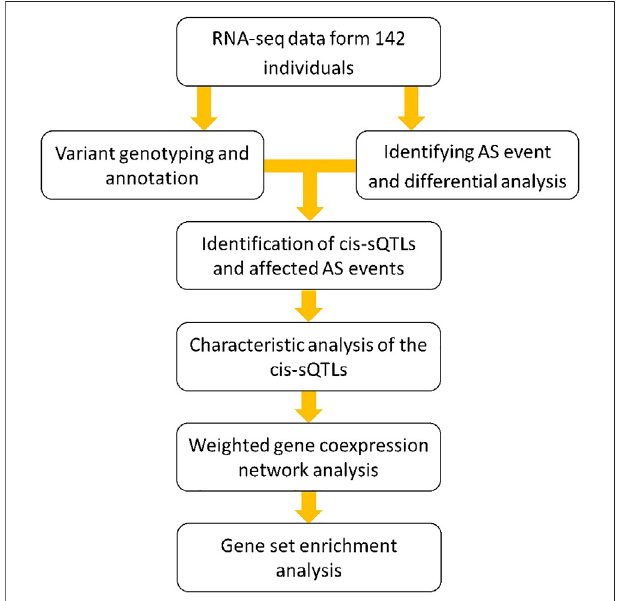
FIGURE1| The fl owchartofthestudydesignforexploring thein fl uence of genome variants on gene AS and their functions to pathogenesis of